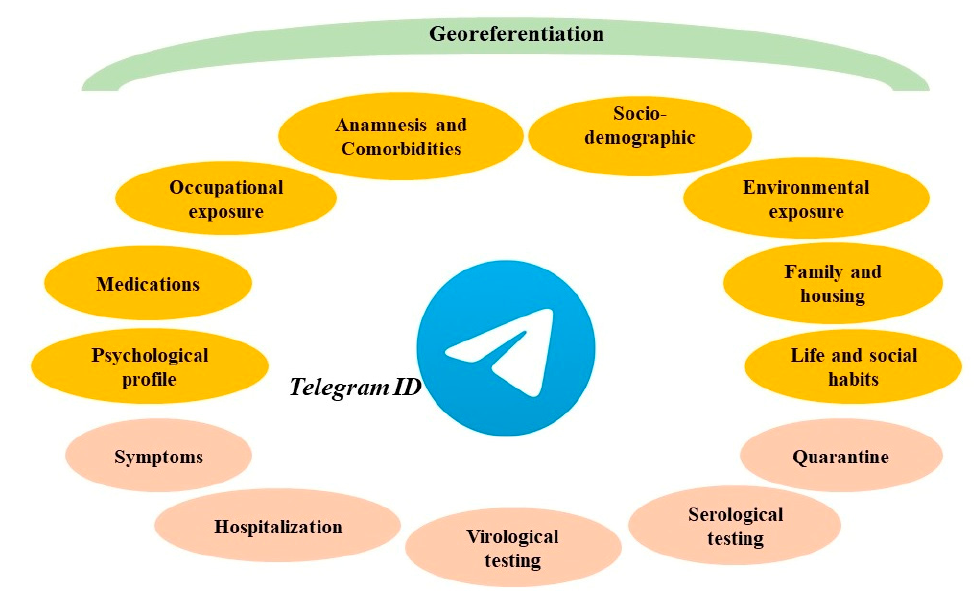
Figure 2. Dress-COV survey sections.